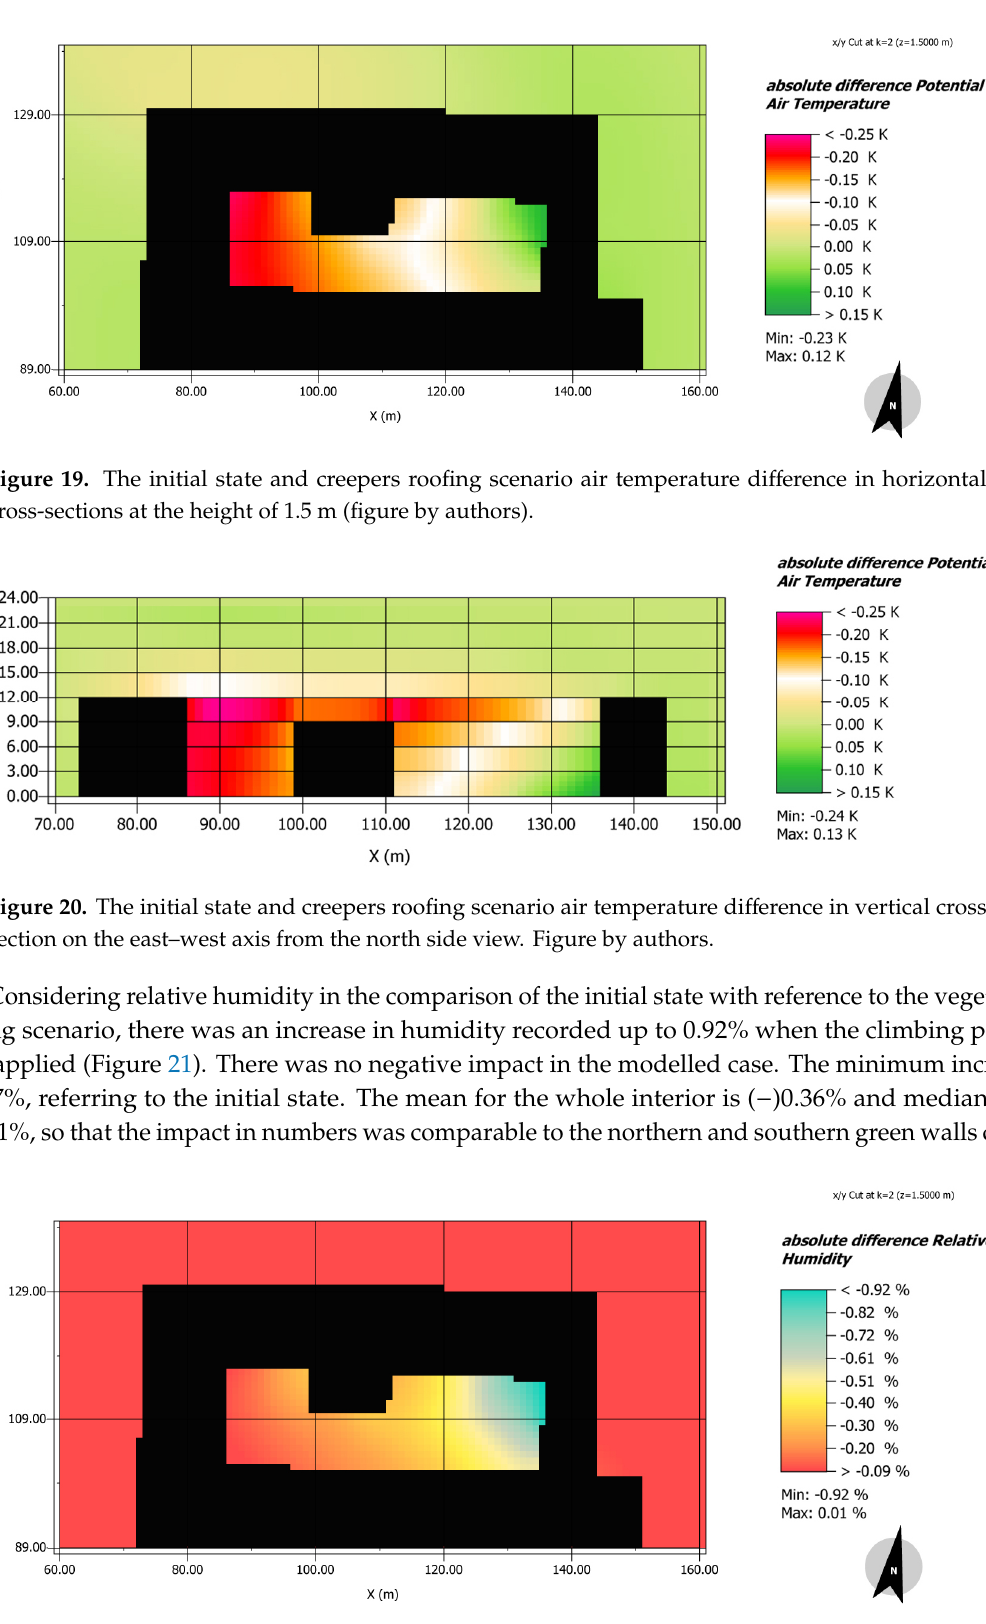
Figure 21. The comparison of initial state with reference creepers roofing scenario relative humidity at the height of 1.5 m. Figure by authors.